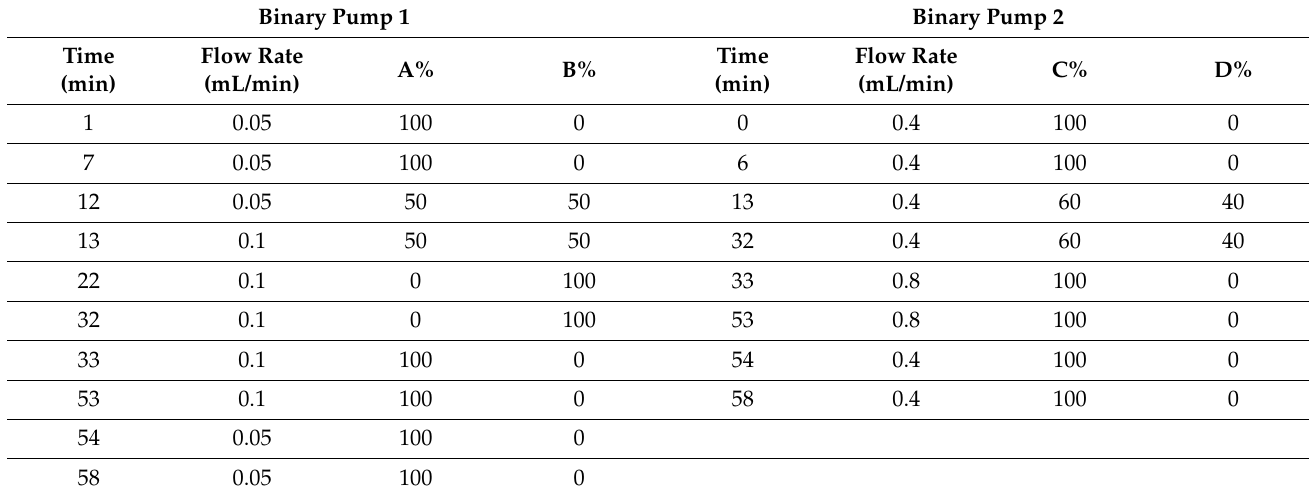
Table 2. Mobile phase condition of